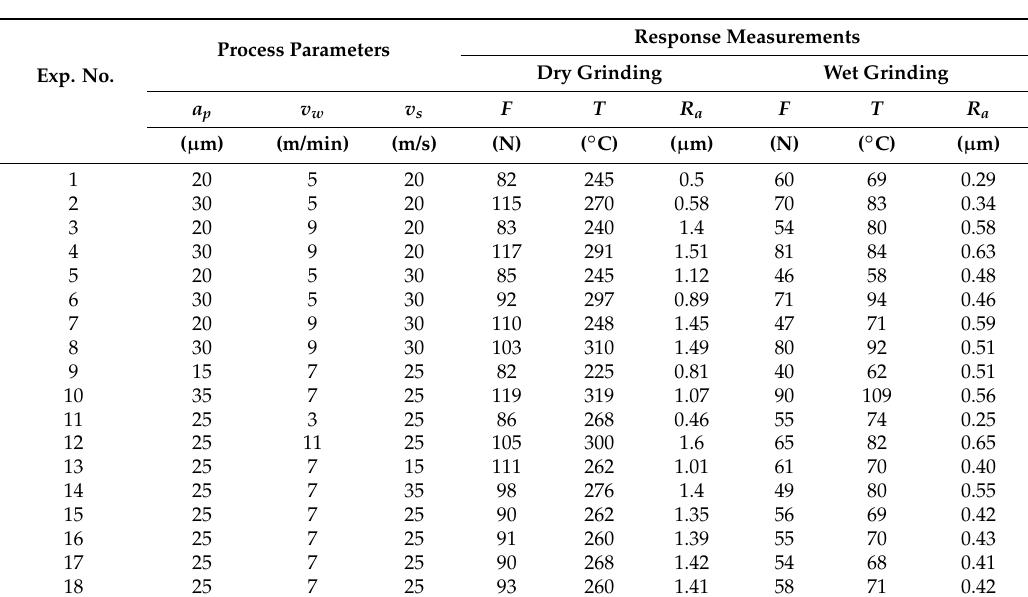
Table 3. Design matrix for dry and wet condition grinding.